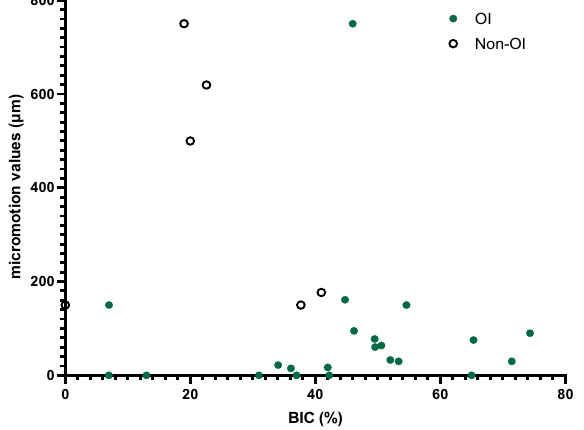
Figure 4. Scatter plot graph of the correlation between micromotion values and percentage BIC for the animal studies. For the osseointegrated data (green filled circles) a positive correlation was found (Spearman’s ρ = 0.41, p value = 0.02). No correlation was observed for the non-osseointegrated data (empty circles), nor the full dataset (all